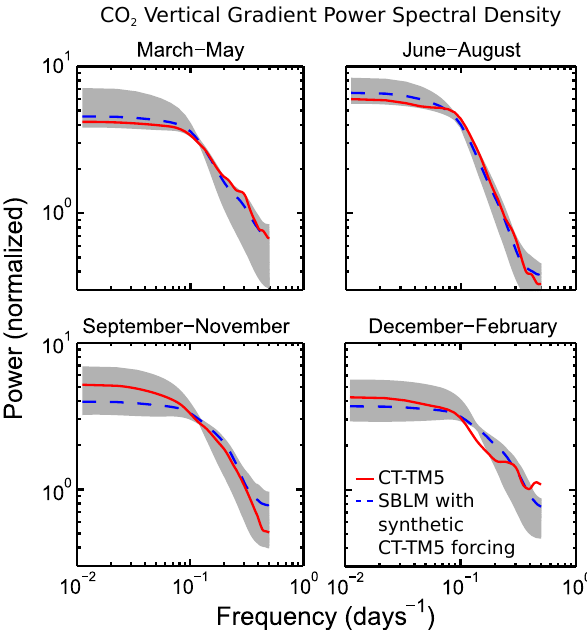
Fig. 3. Normalized power spectral densities for boundary layer CO 2 concentrations predicted by the stochastic boundary layer model (SBLM) with synthetic CT-TM5 forcing (dashed blue), and spectral densities for the original boundary layer CO 2 concentrations from the CT-TM5 data assimilation system (red). The gray shading indi- cates the range of SBLM solutions for 0 < f < 1 . 25, where f is an estimated sub-grid-scale boundary layer entrainment expressed as a fraction of the resolved-scale vertical velocity (see text for details).